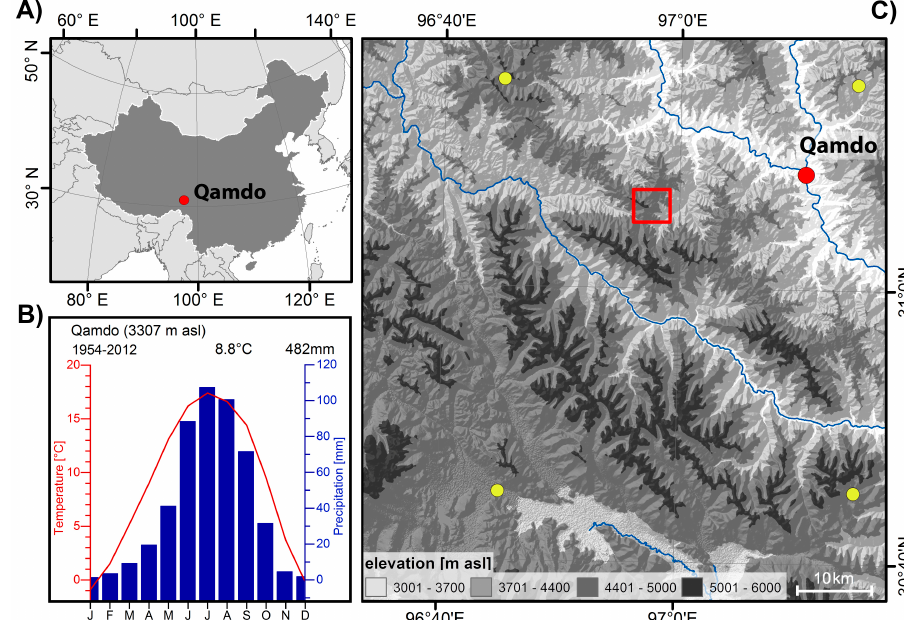
Figure 1. Overview of the investigation site: ( A ) location of the site Qamdo within China; ( B ) climate diagram of the climate station in Qamdo; and ( C ) digital elevation map of the Qamdo region with the investigation site (red box), location of the city and climate station of Qamdo (red dot). Yellow points indicate locations of the used 0.5° CRU TS 4.02 grid points.